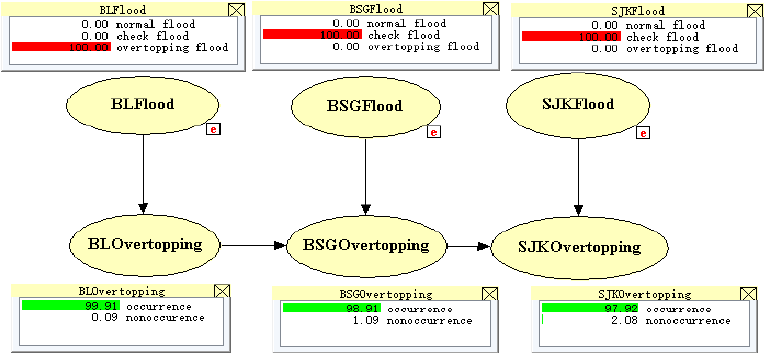
Figure 19. The posterior probability of each dam’s overtopping node on the condition of Flood evidence.